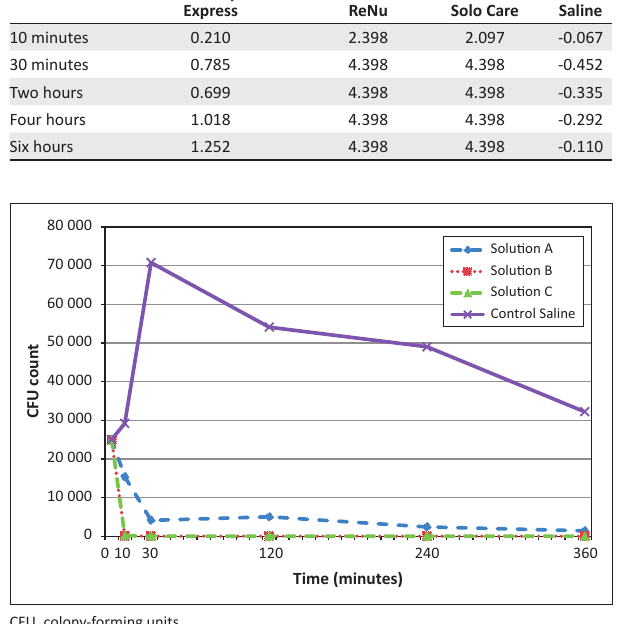
CFU, colony-forming units. FIGURE 1: Actual colony counts per solution per time interval presented